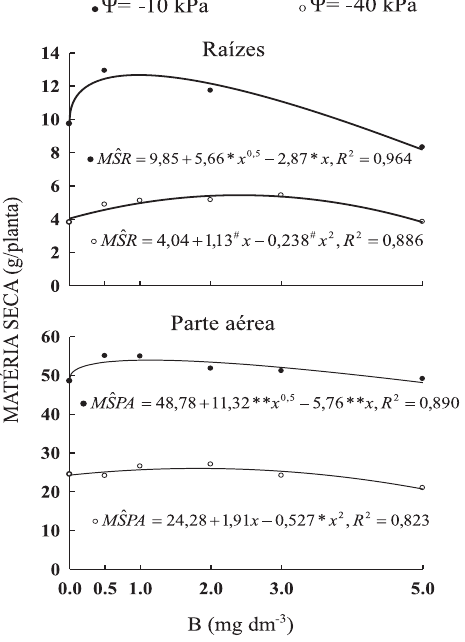
Figura 2. Produção de matéria seca de raízes (MSR) e de parte aérea (MSPA) do eucalipto em resposta às doses de B, considerando o potencial de água do solo ( ΨΨΨΨΨ ). # , * e ** significativo a 10, 5 e 1 %, respectivamente, pelo teste